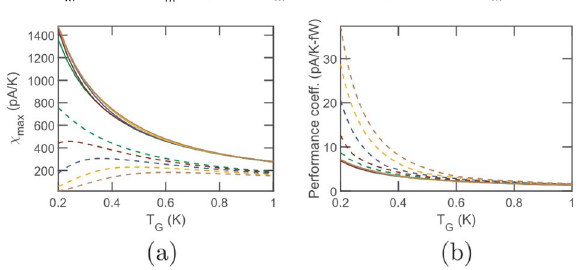
Figure 8. Performance comparison between the dual dot and the triple dot thermometer. Variation in ( a ) maximum sensitivity ( χ max ) and ( b ) Performance-coefficient at the maximum sensitivity with T G for different values of Coulomb coupling energy U m . The solid and the dashed line represent the performance parameters of the triple dot and dual dot thermometers respectively. The system parameters used for simulation are T L ( R ) = 300 mK, and V = 1.1 mV. For the dual dot thermometer, the different system to reservoir coupling are chosen to be γ l (ξ) = γ c θ(ξ 1 s + δξ − ξ) , γ r (ξ) = γ c θ(ξ − ξ 1 s − δξ) and γ g = γ c . For the triple dot thermometer, the system to reservoir, as well as the interdot coupling are chosen to be γ l (ξ) = γ r (ξ) = γ g (ξ) = γ(ξ) = γ c = 10 µ eV. In both the dual dot and the triple dot thermometer, gamma